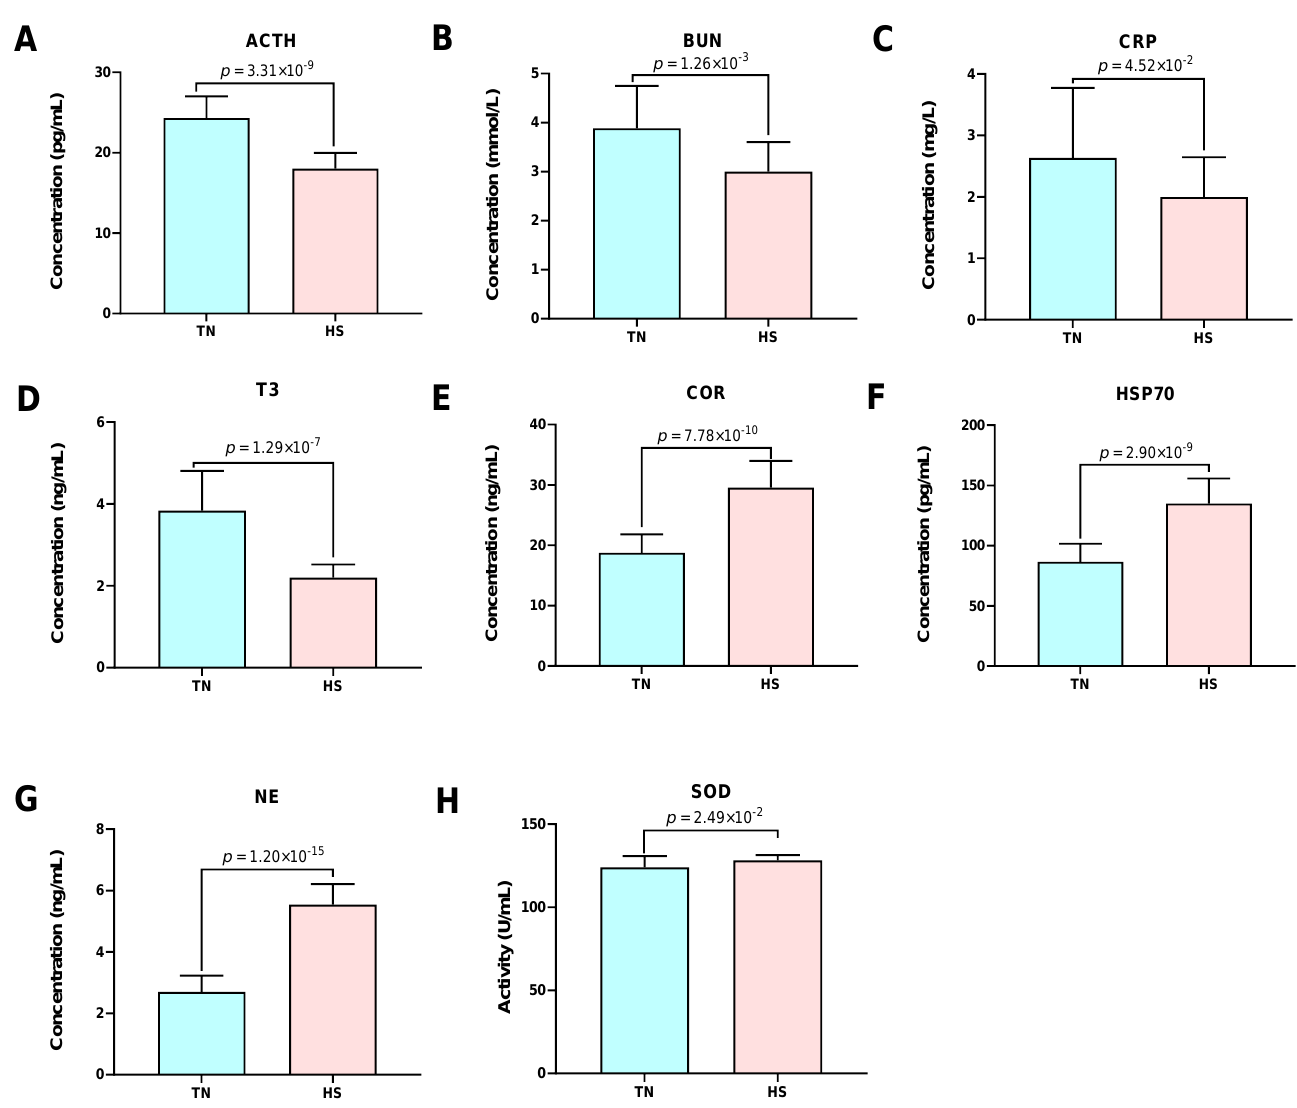
Figure 1. The comparisons of biochemical parameters of Holstein cows between thermal neutrality (TN) and heat stress (HS) conditions. ( A ) The comparison of adrenocorticotropic hormone (ACTH) between two groups. ( B ) The comparison of blood urea nitrogen (BUN) between two groups. ( C ) The comparison of C-reactive protein (CRP) between two groups. ( D ) The comparison of triiodothyronine (T3) between two groups. ( E ) The comparison of cortisol (COR) between two groups. ( F ) The comparison of heat shock protein 70 (HSP70) between two groups. ( G ) The comparison of norepinephrine (NE) between two groups. ( H ) The comparison of superoxide dismutase (SOD) between two groups. Data are represented as means ± standard deviation. p < 0.05 is considered to indicate a statistically significant